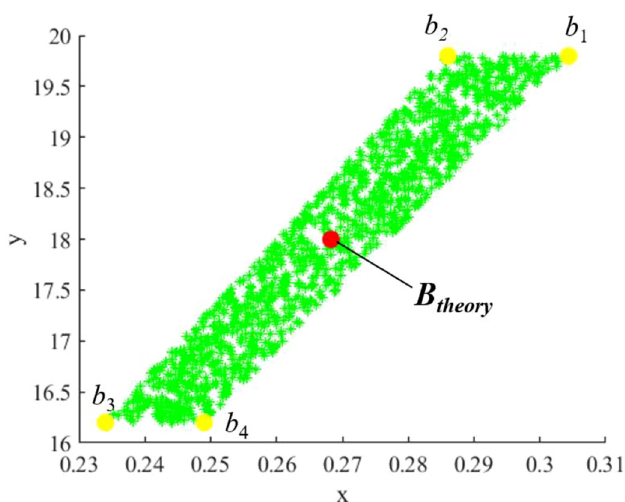
Fig. 4. Simulation